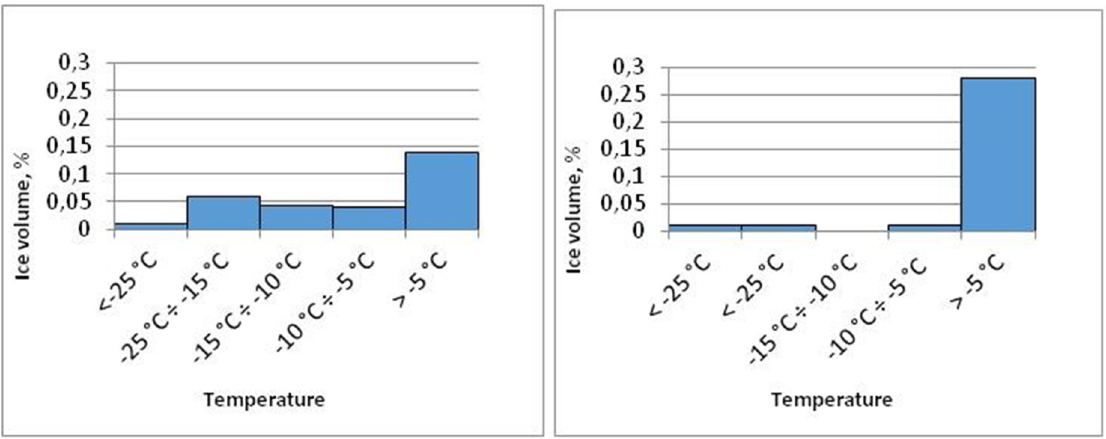
Figure 7. Distribution of ice volume in sample B1—during cooling ( left ) and heating ( right ). Pores with radii > 0.02 µm are the dominant group of pores in the tested material.